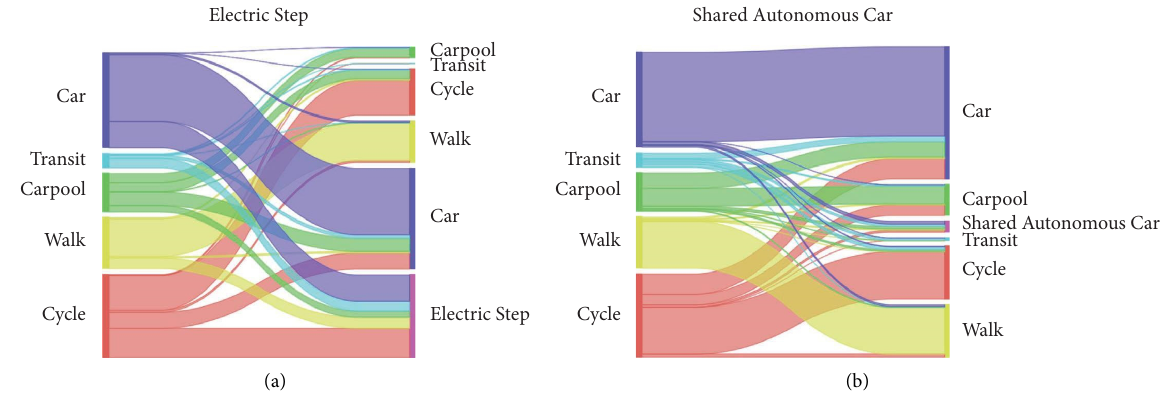
Figure 2: Sankey diagrams of current mode choice (a) and future mode choice (b) on each diagram for the nested logit model. (a) Electric step; (b) a shared autonomous